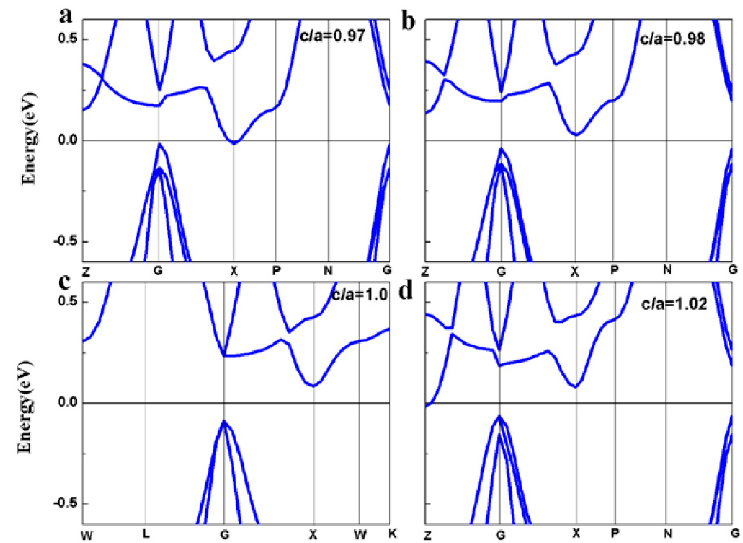
Figure 8. The majority spin band structures around Fermi level at different c/a ratios for FePdCrSi compound ( a ) c/a = 0.97, ( b ) c/a = 0.98, ( c ) c/a = 1.0 and ( d ) c/a = 1.02.